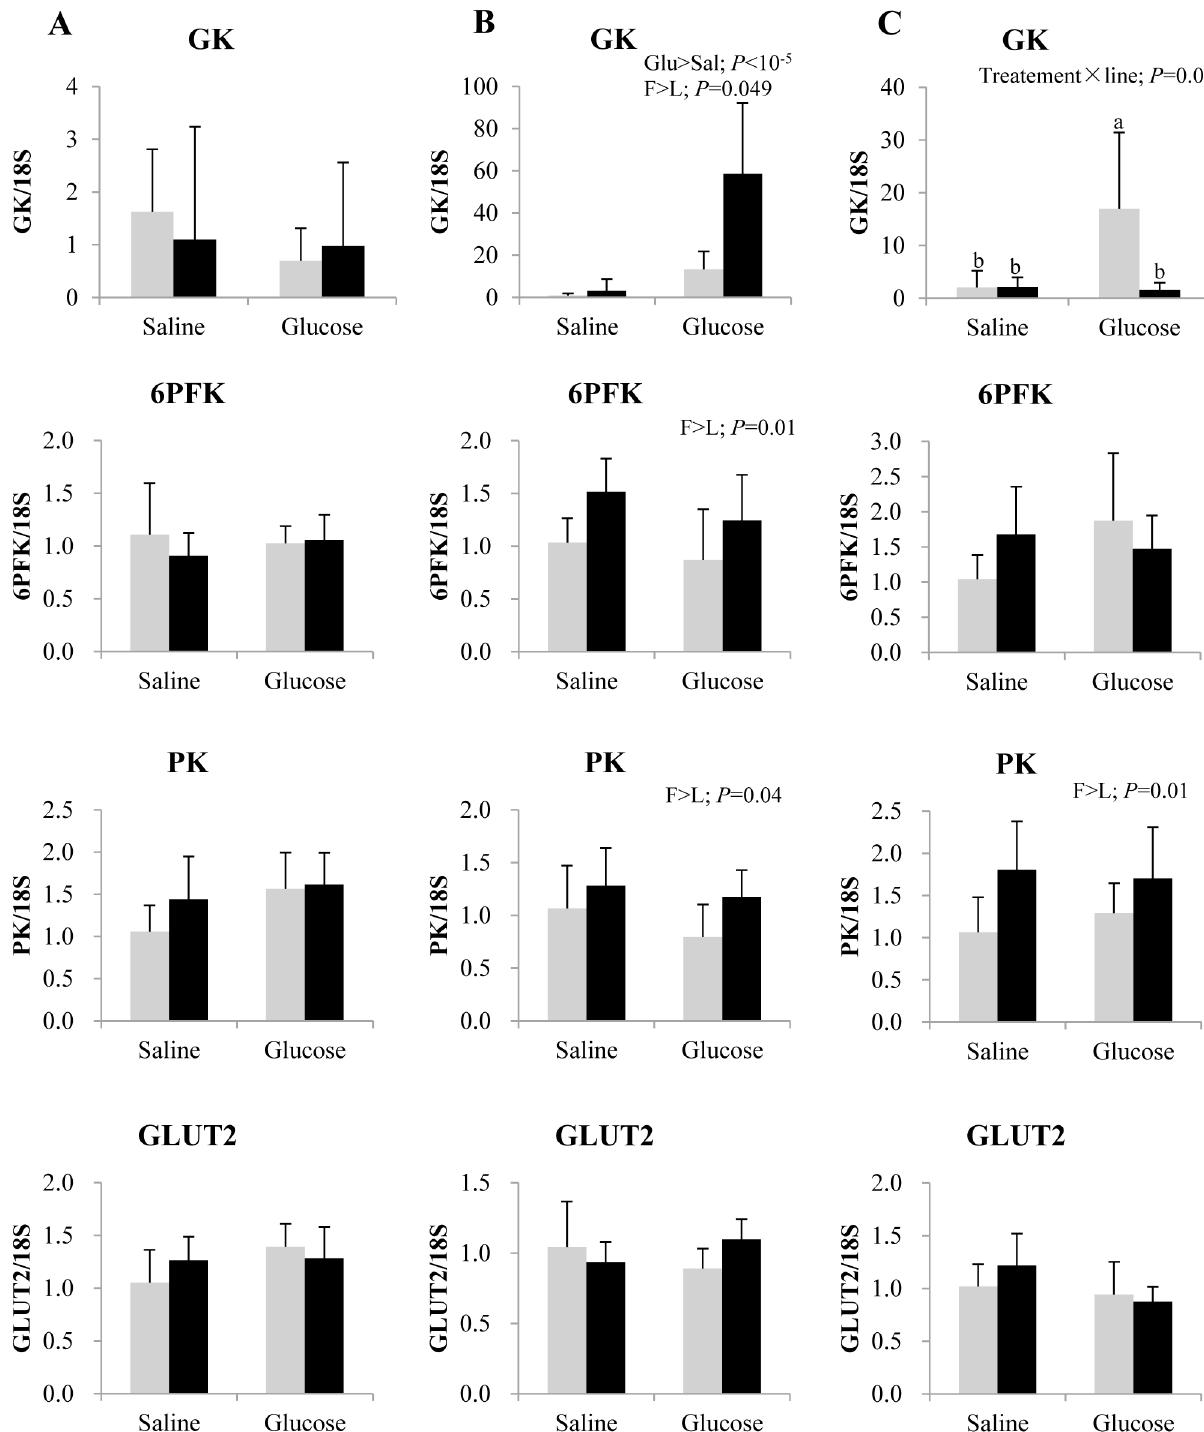
Figure 3. Gene expression of selected glycolytic enzymes and glucose transporter in the liver of rainbow trout from L line (L; grey bars) and F line (F; black bars) at 3 h (A), 8 h (B) and 12 h (C) after IP administration of glucose or saline solution. Glucokinase (GK), 6- phosphofructo-1-kinase (6PFK), pyruvate kinase (PK) and glucose transporter type 2 (GLUT2) mRNA levels were measured using real-time quantitative RT-PCR. Expression values were normalized by 18S-ribosomal RNA transcripts. Results are expressed as means 6 SD ( n =6) and were analyzed using two-way ANOVA ( P , 0.05), followed by a Student-Newman-Keuls multiple comparison test. In case of interaction, mean values not sharing a common lowercase letter are significantly different from each other.